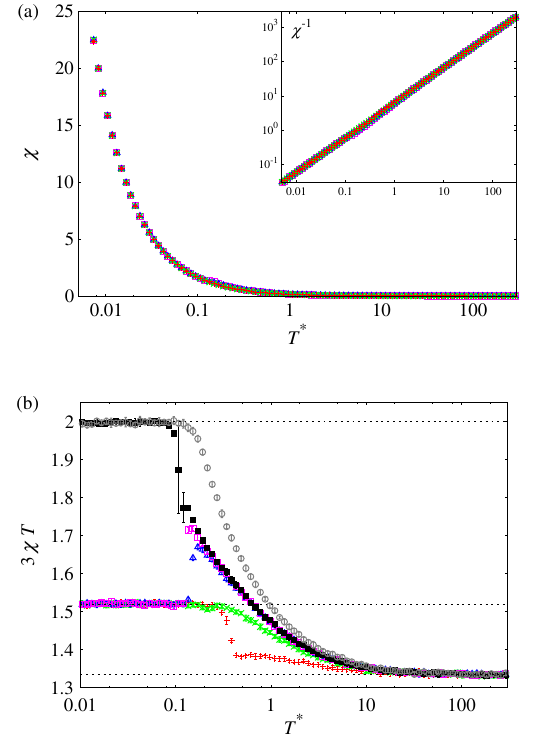
FIG. 6. (a) Magnetic susceptibility (cid:5) as a function of reduced temperature T (cid:4) for chemical potential (cid:2) (cid:4) ¼ 0 : 33 (+), 0.65 ( (cid:6) ), 0.784 ( 4 ), and 0 : 794 ð h Þ < (cid:3)= 2 , where (cid:3) is the Madelung constant. The inverse susceptibility is plotted in the inset on a log-log scale. (b) Curie-law crossover 3 (cid:5)T vs T [same color labeling with two additional values of (cid:2) (cid:4) ¼ 0 : 801 ð j Þ and 0.98 ( (cid:7) ) >(cid:3)= 2 ]. The dashed lines are theoretical expectations for the spin-liquid Curie-law prefactor C of the Coulomb phase ( C (cid:5) 2 ) and the singly charged monopole fluid ( C ¼ 4 = 3 ), while the one for C ¼ 1 : 52 is a guide to the eye. Equilibration has been ensured down to T ¼ 20 mK ( T (cid:4) (cid:5) 0 : 007 ) by the worm algo- rithm. (See Appendix B for more